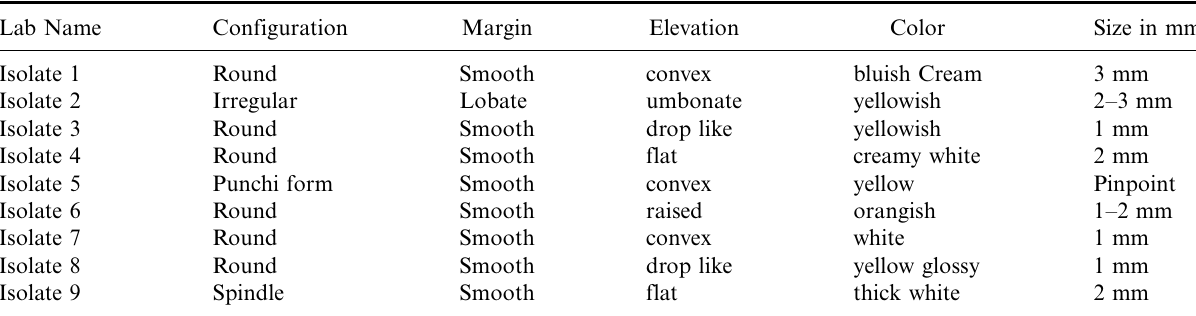
Table 1. Morphological characteristics of isolated